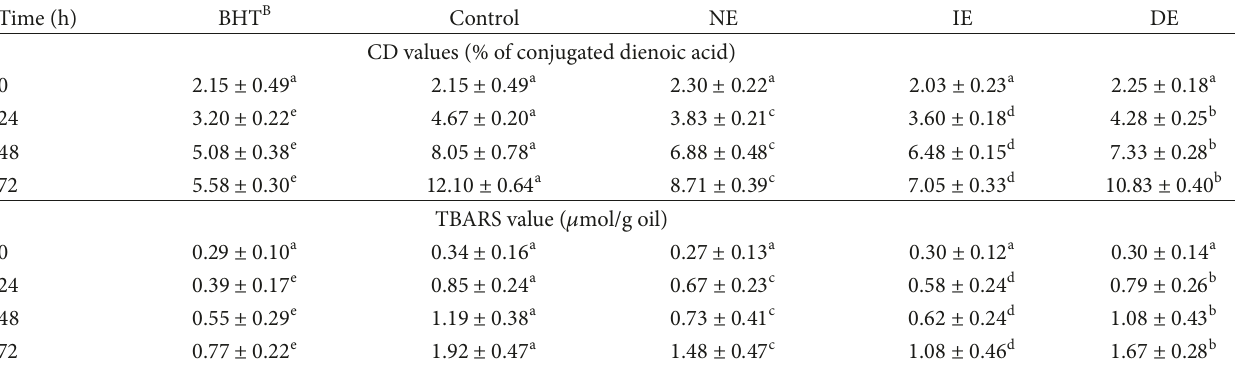
Table 3: Conjugated diene (CD) and TBARS values of corn oil stabilized by camellia oil cake phenolic extracts (0.5%) and BHT (0.02%) during different storage time at 50 ∘ C A